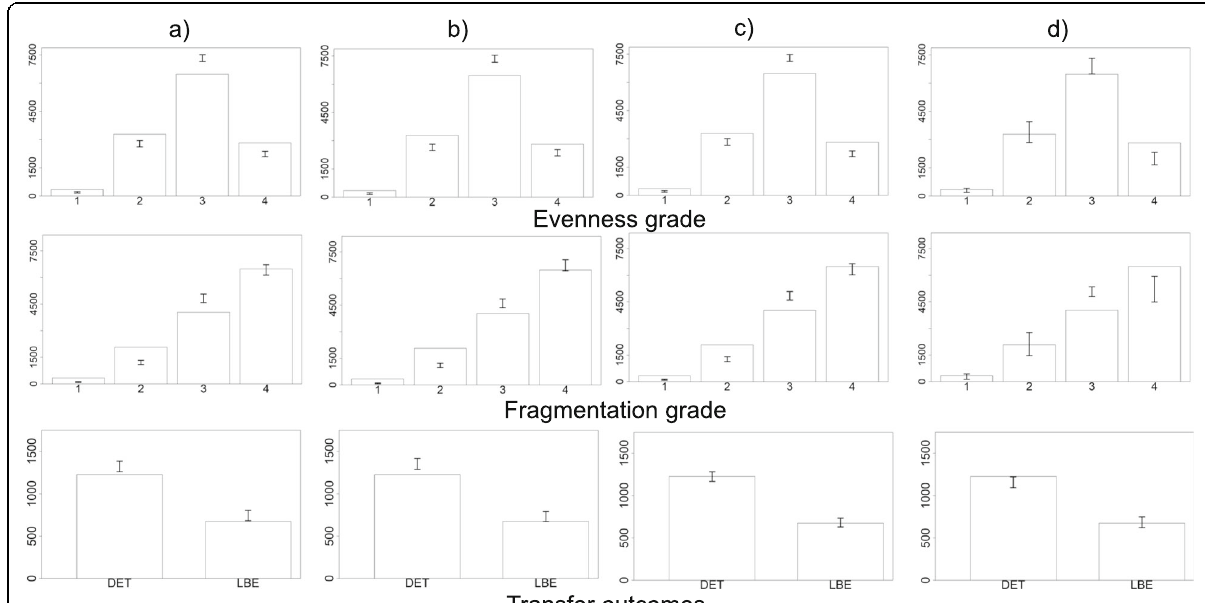
Fig. 3 95% posterior predictive intervals (error bars) for embryo evenness, embryo fragmentation, double embryo transfer and live birth, obtained from a ) pre-treatment separate, b ) pre-treatment joint, c ) dynamic separate, d ) dynamic joint models, plotted with observed stage-specific responses. DET, double embryo transfer; LBE, live birth